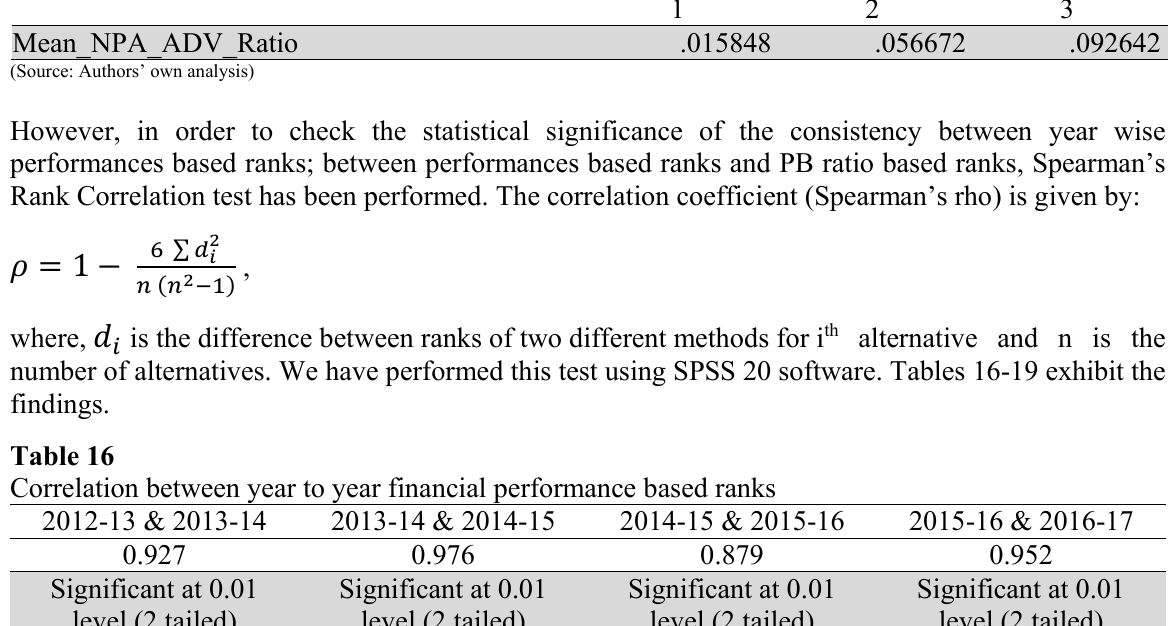
Significant at 0.01